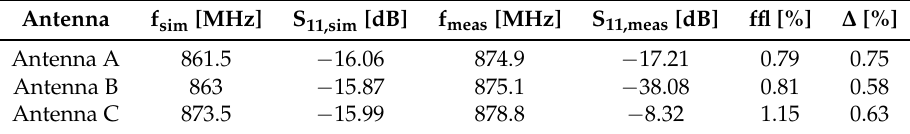
Table 1. Comparison of resonant frequencies and reflection